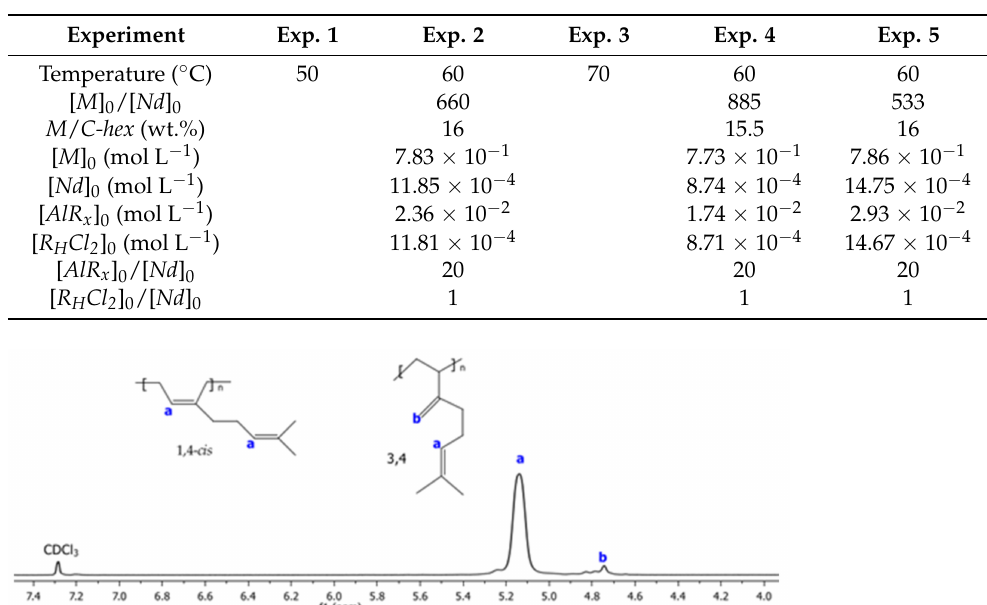
Table 1. Initial concentrations, operating conditions of the CCTP reactions.